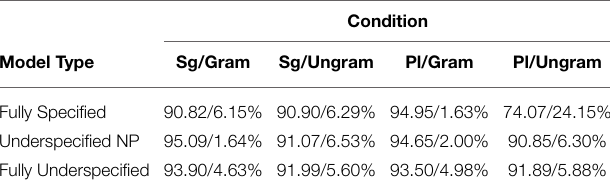
TABLE 4 | ACT-R Retrieval rates for the target/attractor NPs in 10,000 model runs.